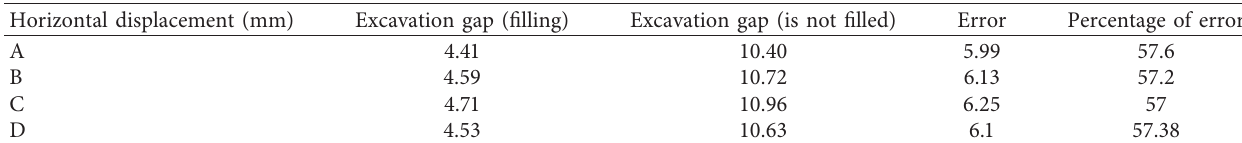
Figure 28: Sewage pipe displacement. Table 6: Sewage pipe measuring point horizontal